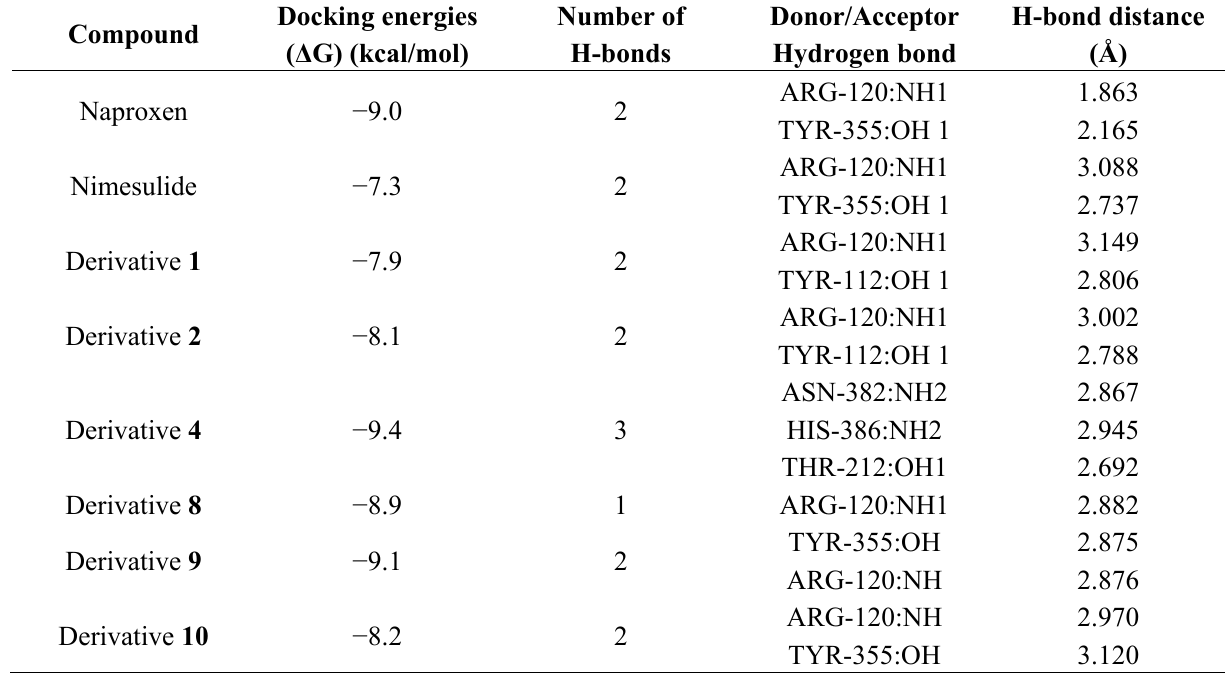
Table 2. Energy contributions for derivatives ( 1 , 2 , 4 , 8 , 9 , 10 ) with high binding energies.